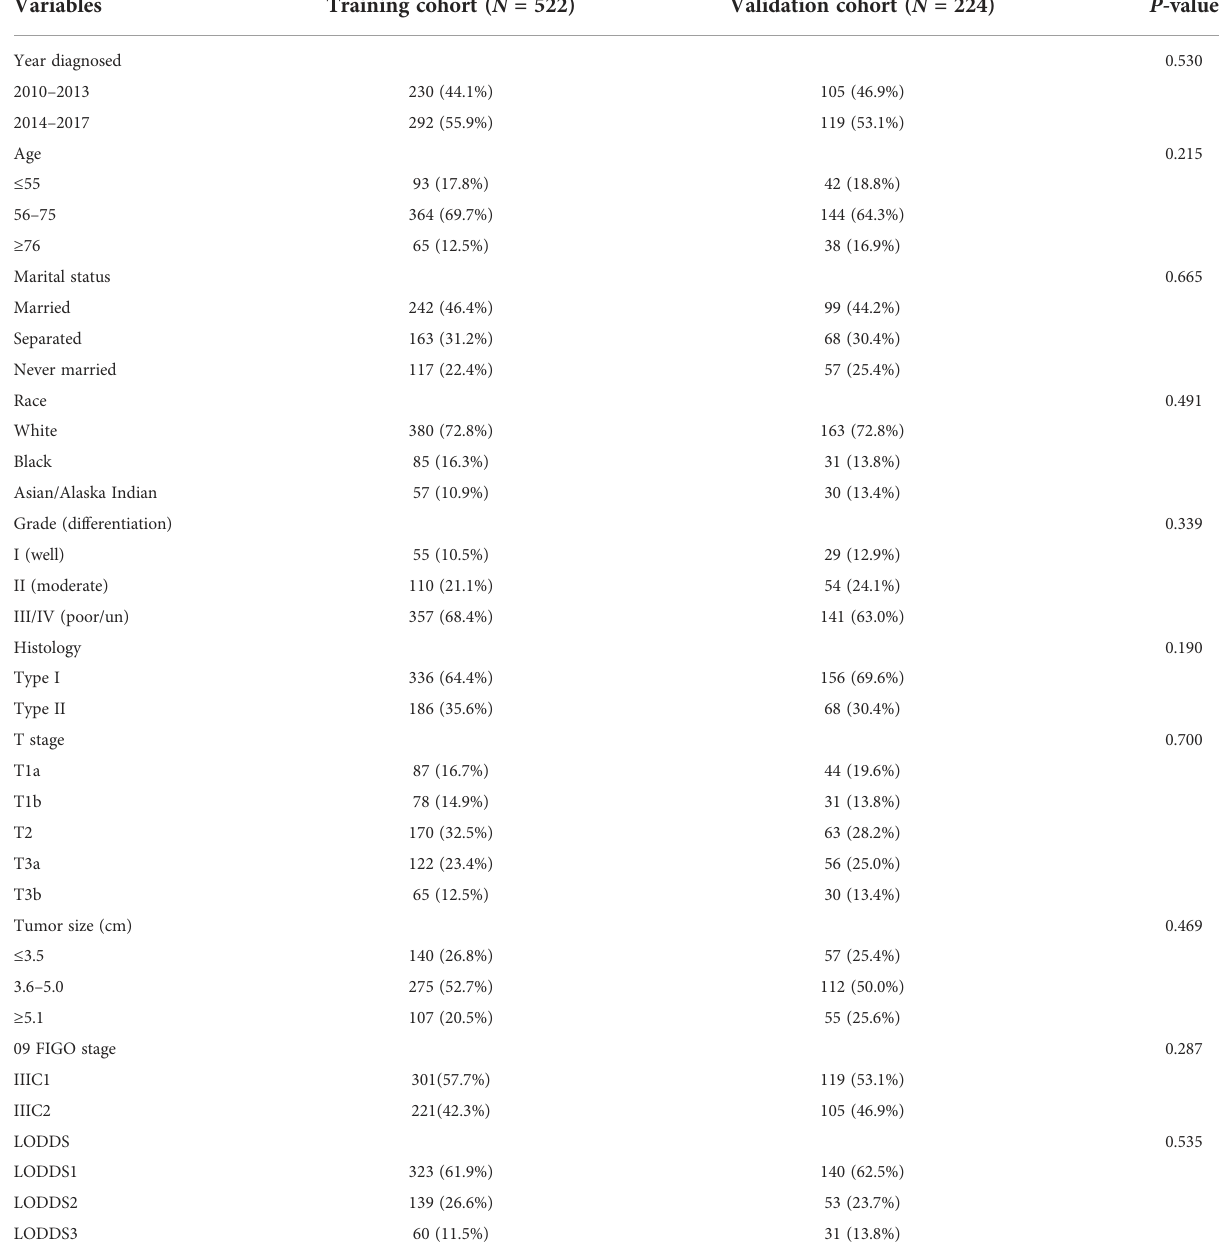
FIGO, Federation International of Gynecology and Obstetrics; LODDS, log odds of positive lymph